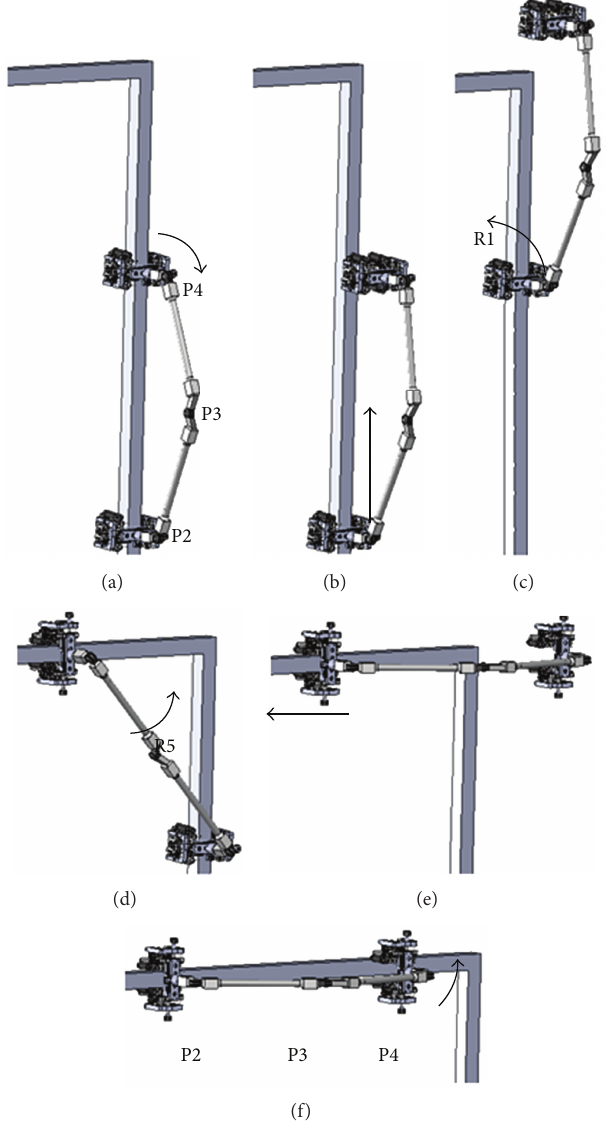
Figure 9: The proposed turning